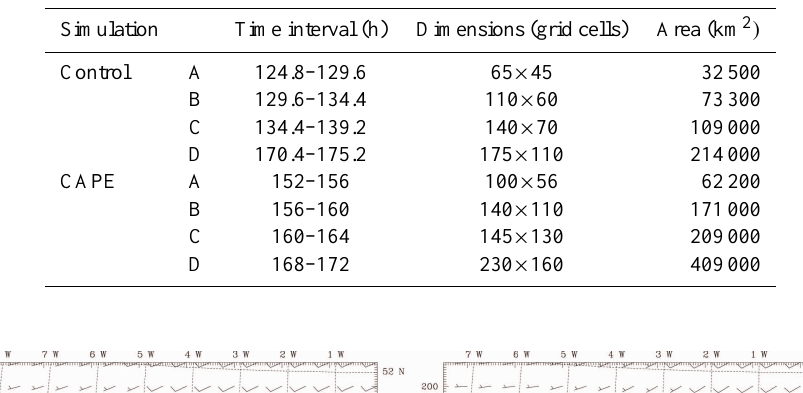
Table 2. Analysis box characteristics.